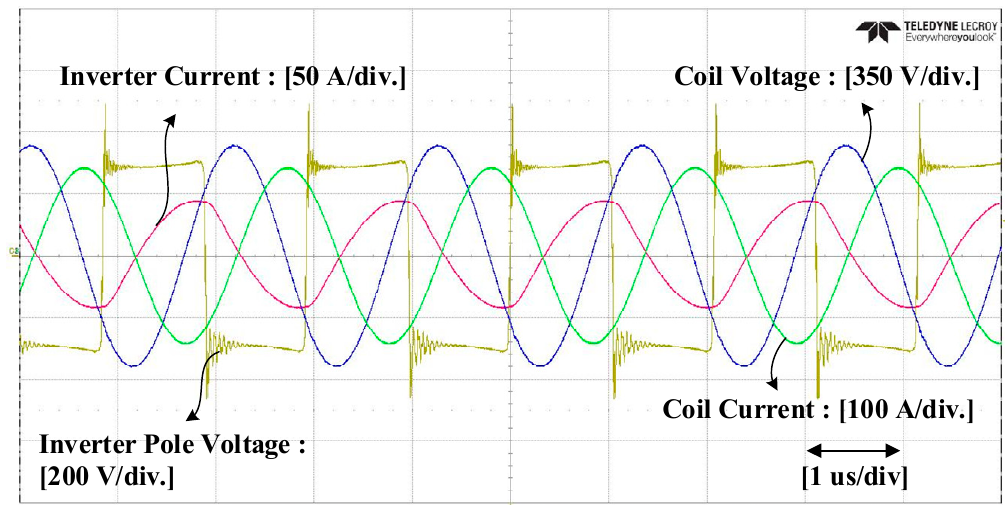
Figure 17. Experimental waveforms of the wafer cleaning equipment.